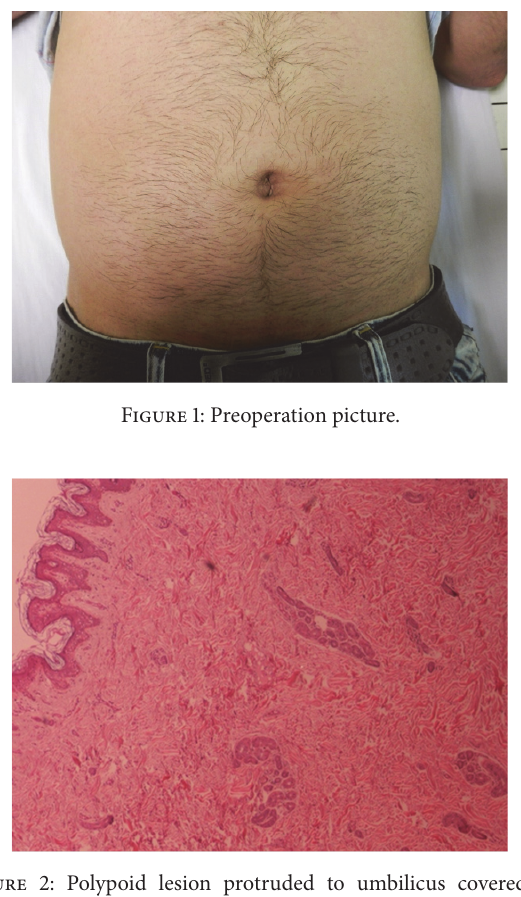
Figure 3: Prominent increase in eccrine coils and dermal